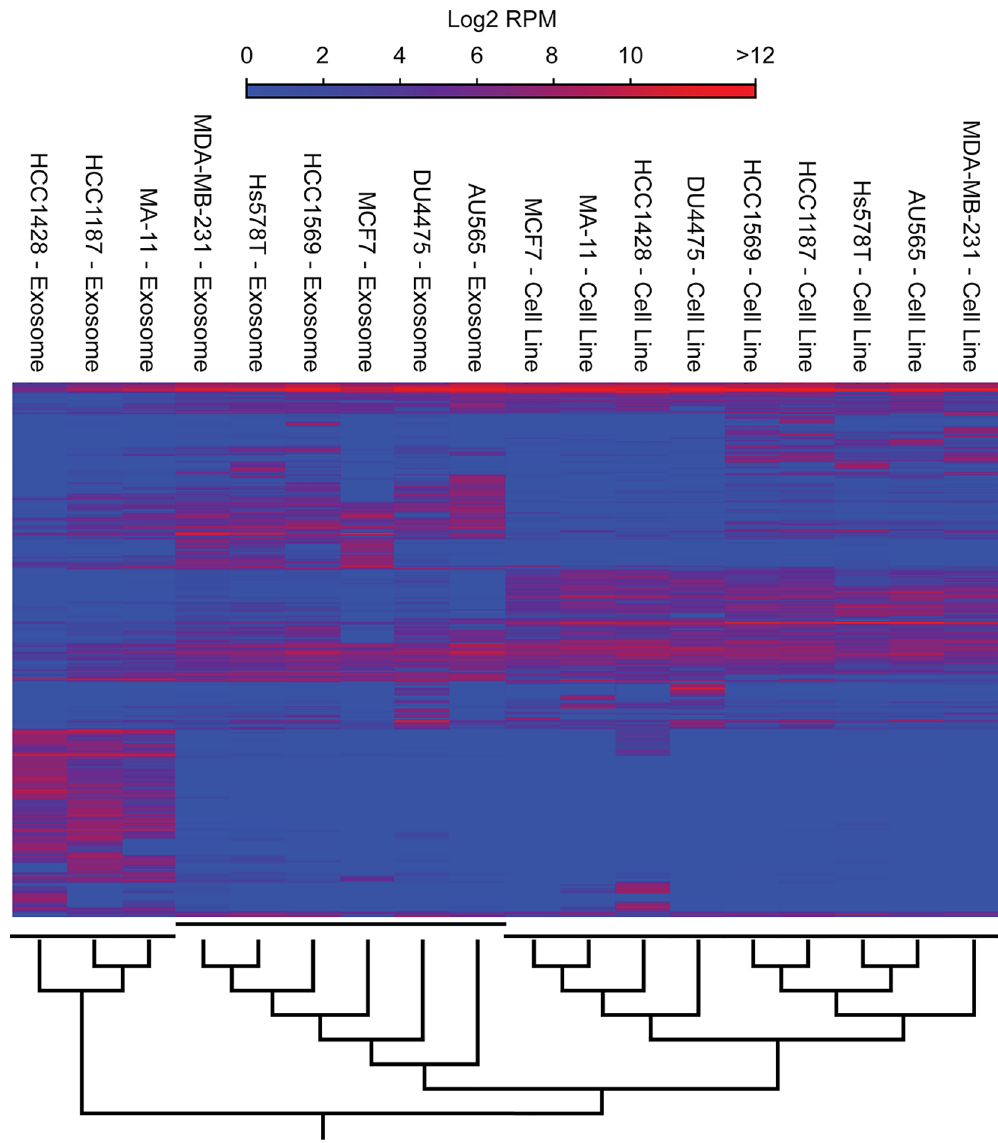
Fig 2. Hierarchical clustering of breast cancer cell lines and corresponding EVs on the basis of expression of 6375 unique small RNAs.